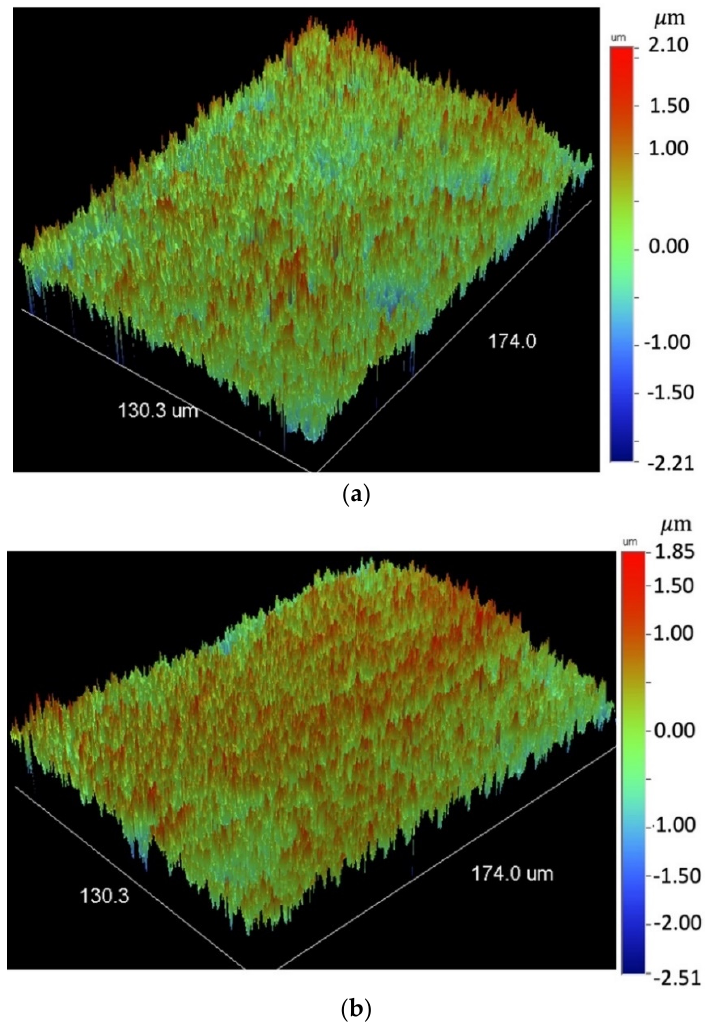
Figure 11. 3D surface profile at 50× magnification for laser-interference raster processed with F 1 = 2.785 J/cm 2 per pulse (5 mm spot size): ( a ) 2 mm/s and ( b ) 6 mm/s. F 2 per pulse (5 mm spot size): ( a ) 2 mm/s and ( b ) 6 1 = 2.785 J/cm